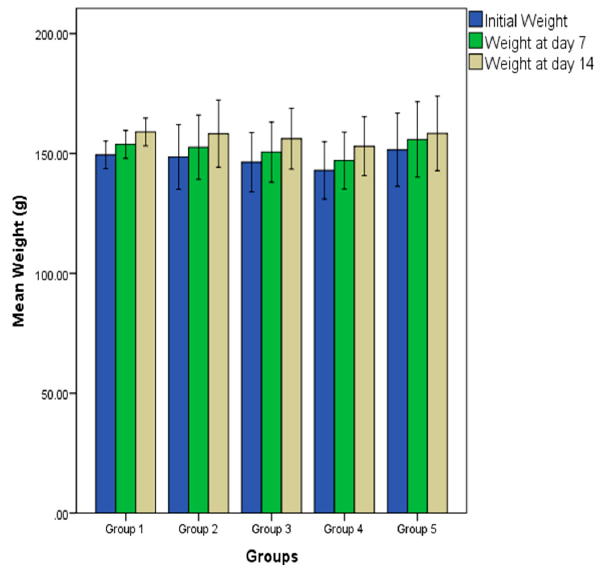
Figure 1. Effect of repeated oral administration of P. dactylifera seed essential oil on weight of Wistar